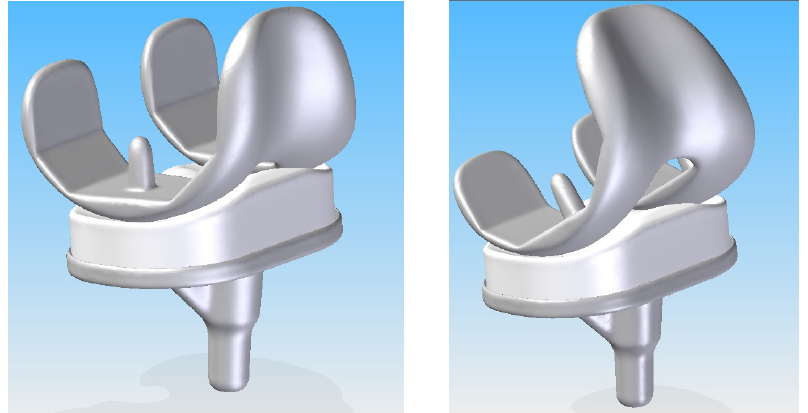
Figura 5: Modelli CAD della protesi: a sinistra la configurazione a 0°, a destra quella a 30°. Figure 5: Knee prosthesis CAD models: 0° (left) and 30° (right) configuration.